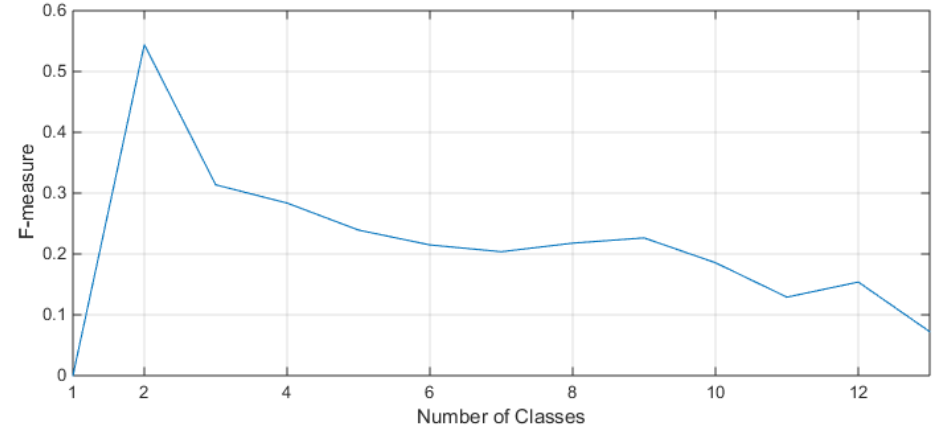
Figure 10. Influence of the number of classes for the F-measure of the BOVW method.